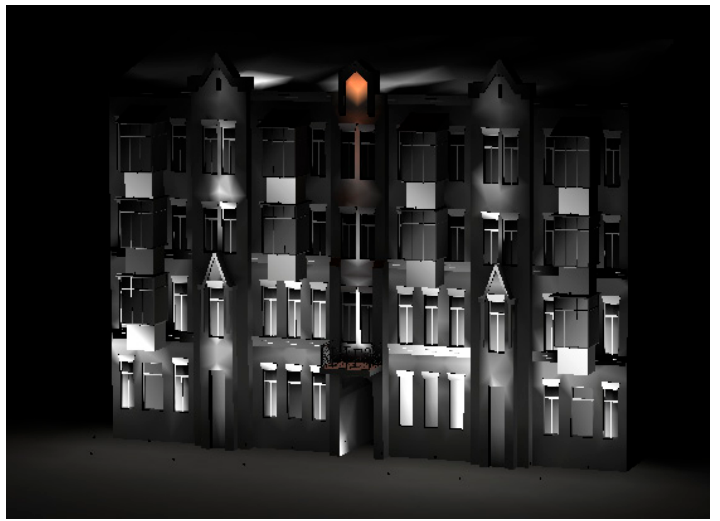
Figure 26. Fast communication of impressionism based on Monet’s painting “Impression”—Scene 1. Designs 2021 , 5 , x FOR PEER REVIEW